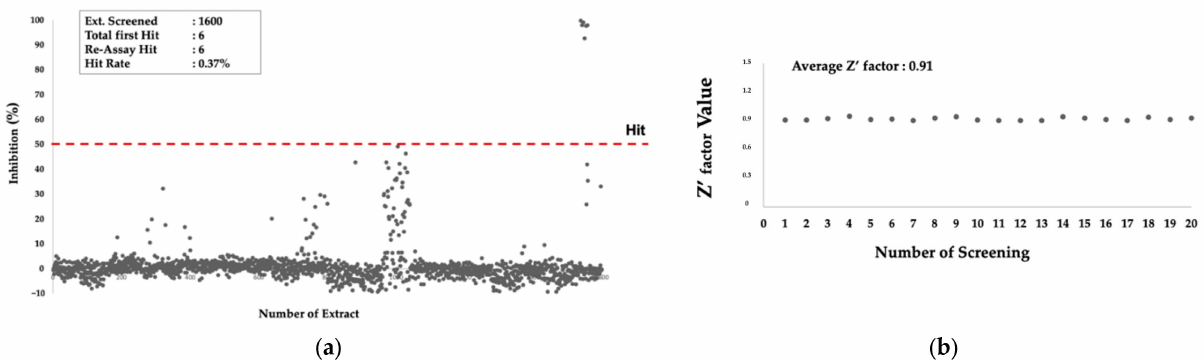
Figure 2. Primary screening of microbial extracts against Pf MQO. ( a ) Inhibitory activity of 1600 mi- crobial extracts against Pf MQO; red-dashed line represents threshold line; ( b ) z’factor value of each assay